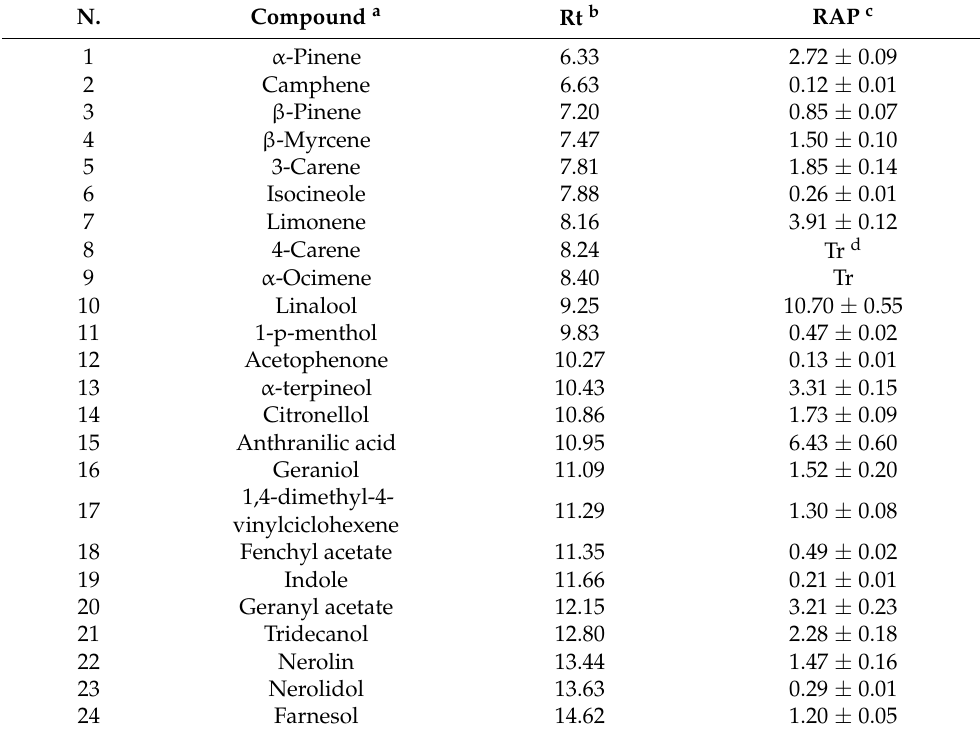
Table 1. Gas chromatography–mass spectrometry (GC-MS) analysis.